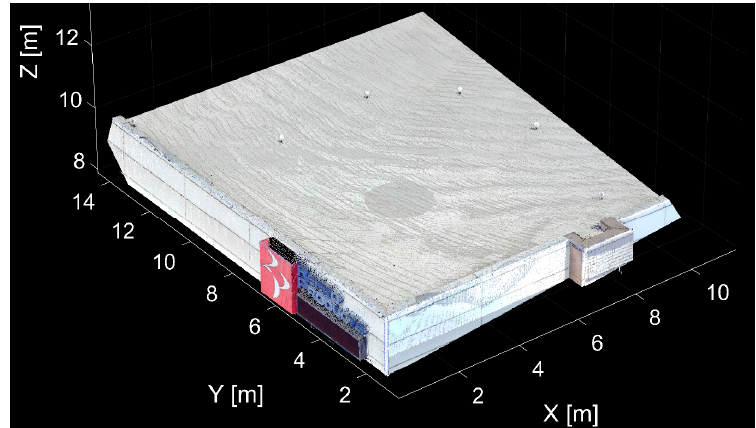
Figure 5. The initial point cloud of a part of an industrial